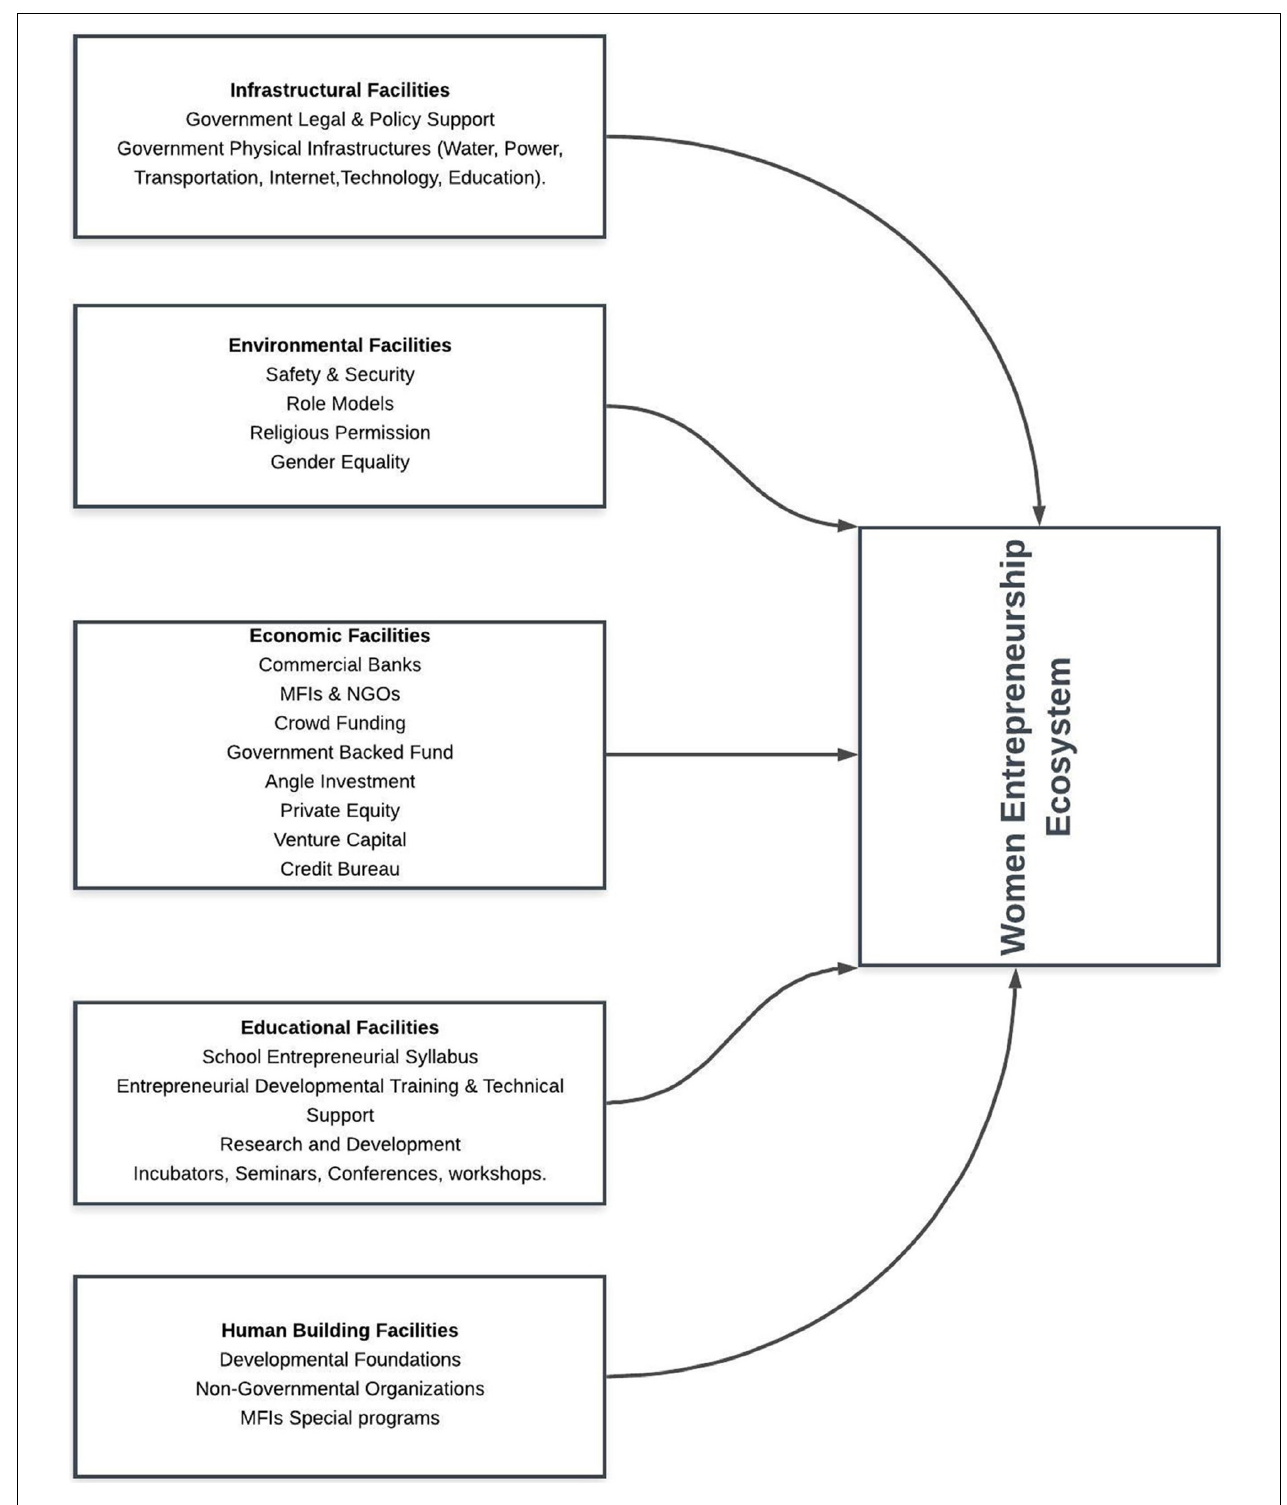
FIGURE 1 | Proposed framework for women entrepreneurship ecosystem in Yemen. Source: Modified from Isenberg (2011).